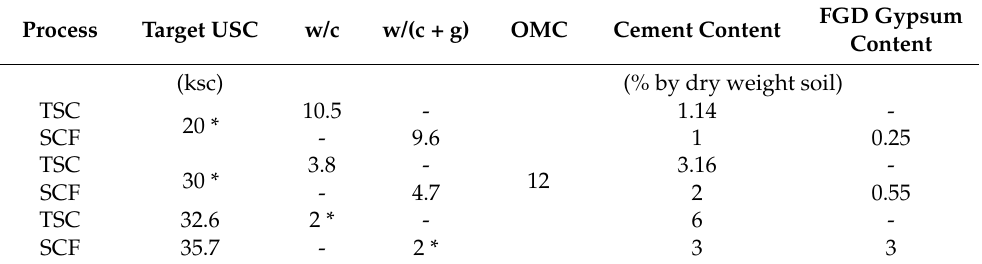
Figure 17. UCS–w/(c + g) relationships. Note : Color of shape: dark, orange, and blue represents C1, C2, and C3, respectively. Special color of shape: gray means the value is not used to create the USC–w/(c + g) relationships. Shape: circle, triangle, square, and diamond represent G0, G1, G3, and G5, respectively. Table 7. The different proportions of the traditional soil–cement (TSC) materials and the soil–cement–FGD gypsum (SCF) materials corresponding to given USC values.